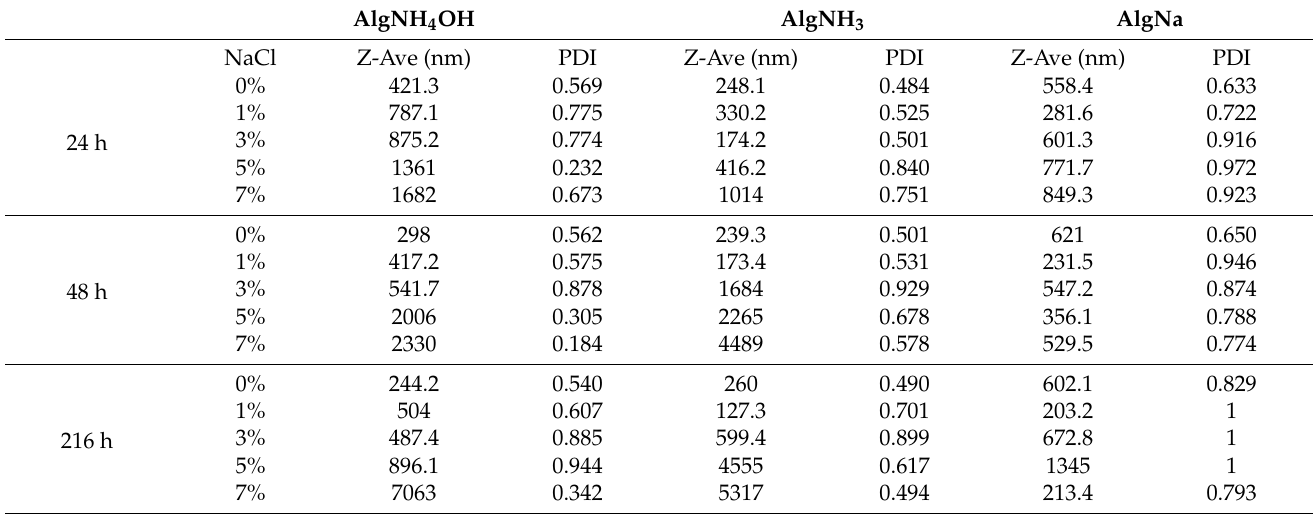
Table 4. The size of particles (Z-Ave) and the polydispersity index (PDI) of diluted solutions of sodium alginate and ammonium alginate in the presence of NaCl.